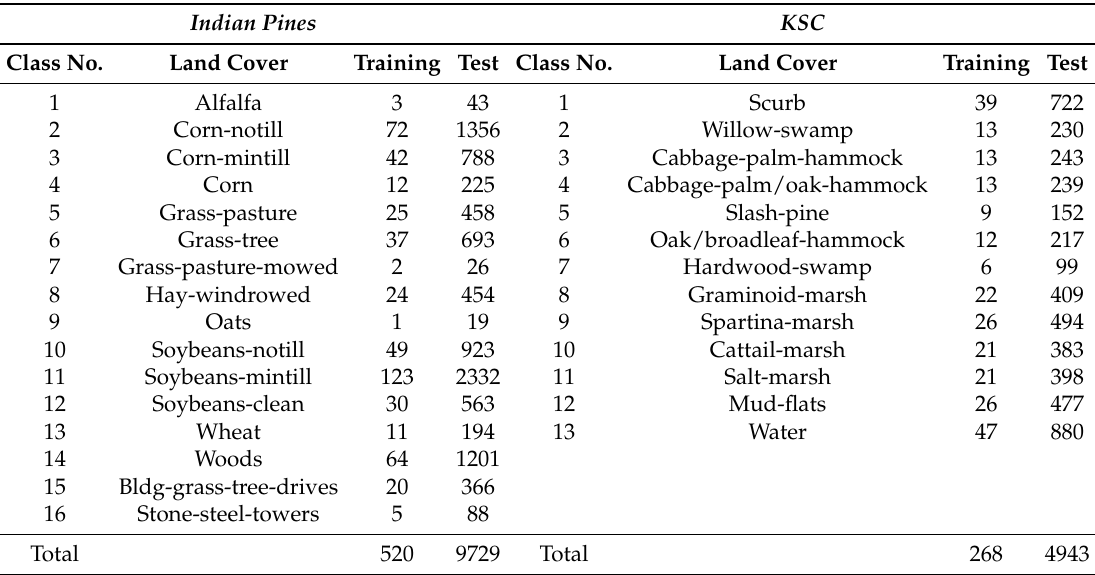
Table 1. Land-cover classes with the number of training and test samples for the Indian Pines and KSC . Indian Pines KSC Class No. Land Cover Training Test Class No. Land